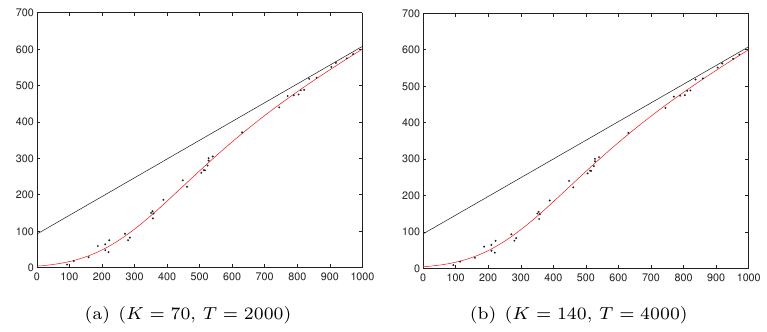
Figure 2. Graphic representation of the synthetic data points { t k ,y k } K modified Richards (2) model F R ( t ; p,q,θ ) = ( pt + q ) f R ( t ; θ ) and its asymptote at the optimal solution ( p ∗ ,q ∗ ,θ ∗ ).